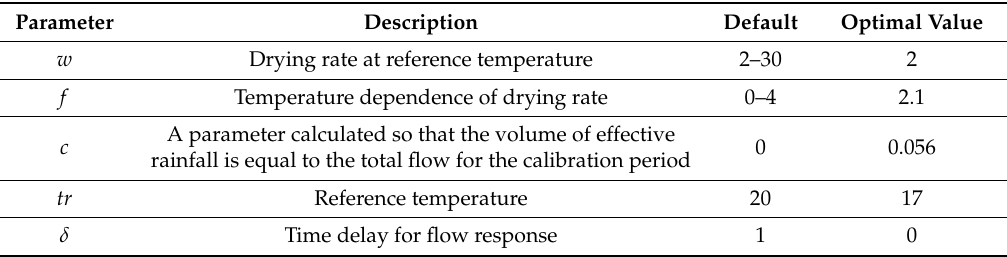
Table 3. Description, default and optimal values used in the model calibration/validation of the IHACRES (identification of unit hydrographs and component flows from rainfall, evapotranspiration and streamflow data)